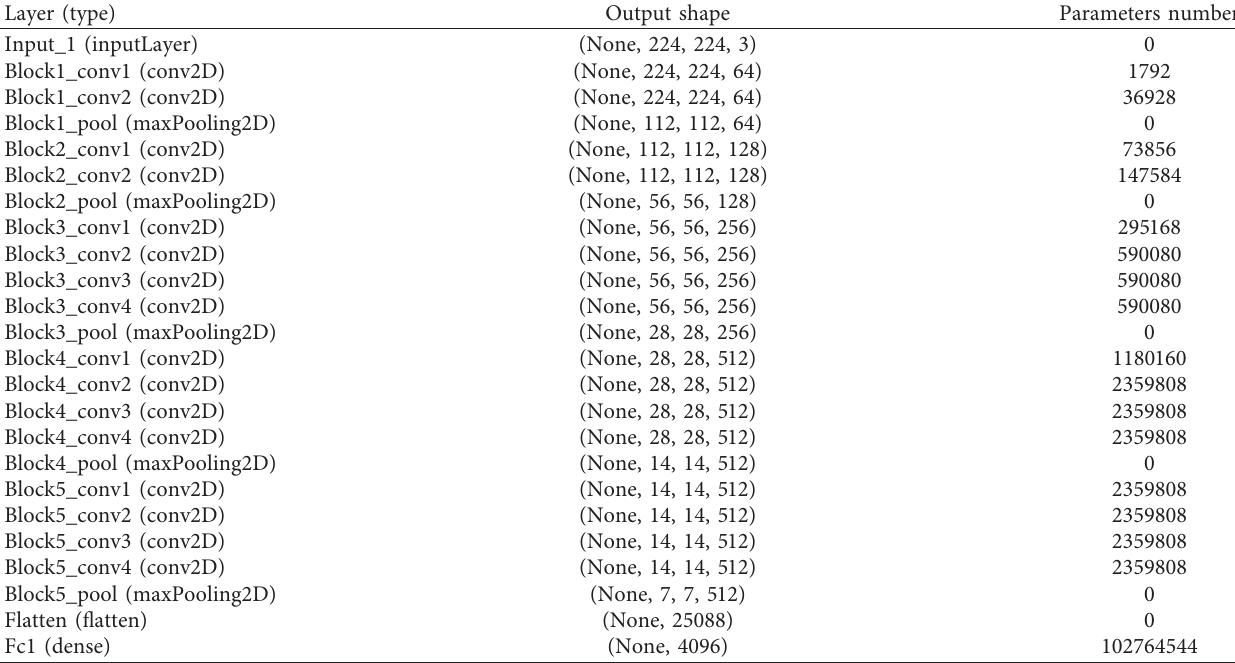
Table 1: VGG19 model for the proposed